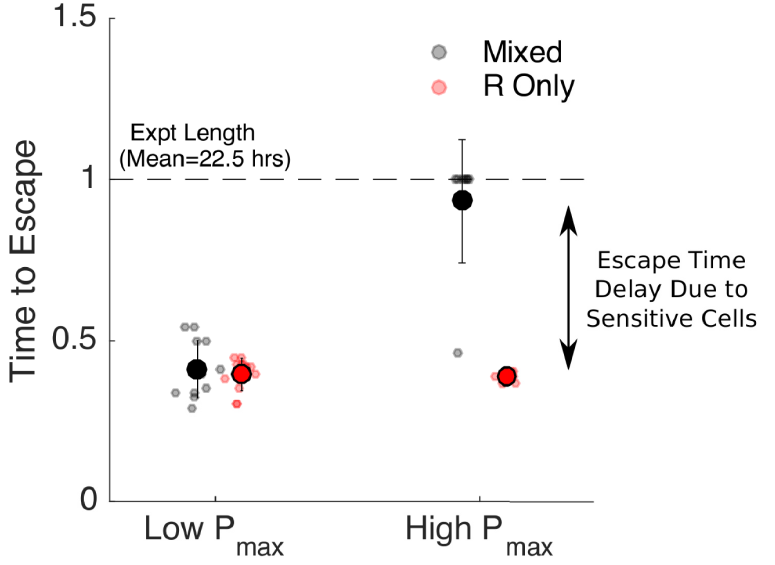
Fig 4. Increased escape time under “competition maximization” requires a high threshold density. Time to escape for populations maintained at low ( P = 0.1, left) and high ( P = 0.2, right) threshold densities (“acceptable max max burdens”). Small circles: escape times for individual experiments in mixed (black) or R-only (red) populations. Large circles: mean escape time across experiments, with error bars corresponding to ± 1 standard deviation. Time to escape is defined as the time at which the population exceeds the threshold OD of P +0.025, in which the 0.025 is padding max provided to account for noise fluctuations. Time to escape is normalized by the total length of the experiment (mean length 22.5 hours). Note that in the high P case (right), the mixed population (black) reached the threshold density max during the course of the experiment in only one case, so the escape times are set to 1 in all other cases. Data are deposited in the Dryad repository: https://doi.org/10.5061/dryad.s4mw6m943 [62]. OD, optical density; P , max acceptable burden; R, resistant.